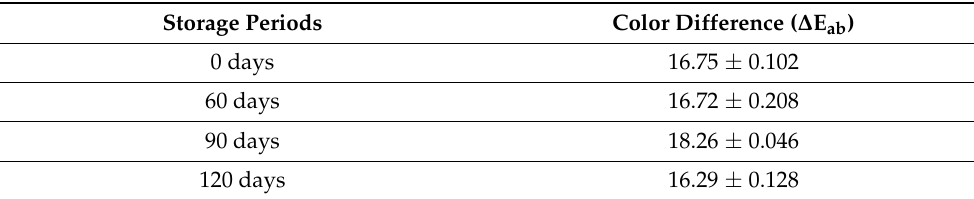
Table 2. Color evaluation of various